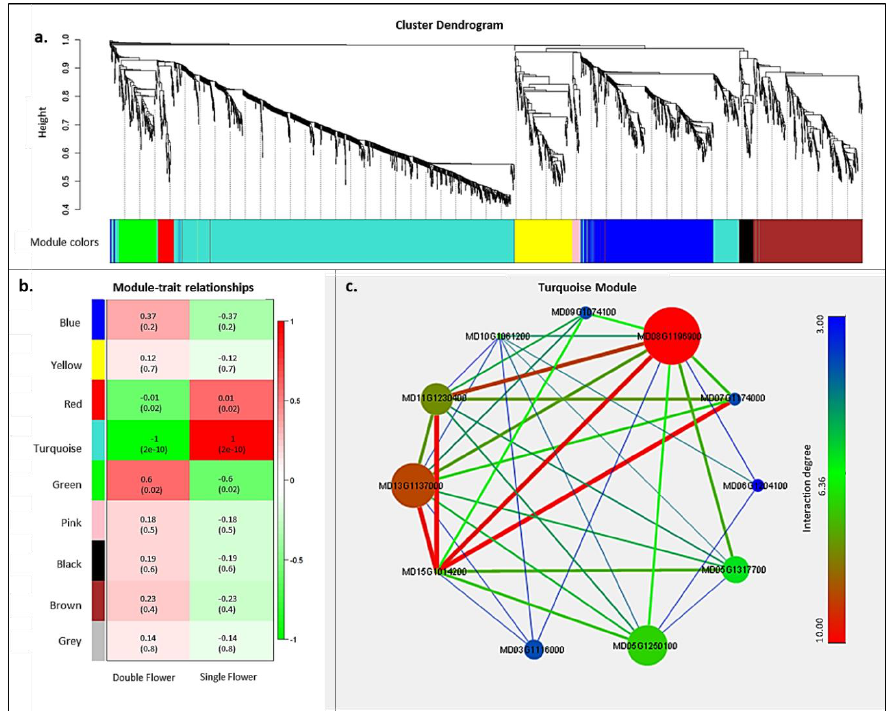
Figure 8. Weighted gene co-expression network analysis (WGCNA) of DEGs identified from double flower and single flower comparison. ( a ) Hierarchical cluster tree showing nine modules of co-expressed genes. Each of the DEGs used in this analysis is represented by a tree leaf and each of the modules by major tree branch. The panel below shows the colors representing each module. ( b ) Module-trait relationships (correlation) and corresponding p -values (given in parenthesis). On the left side the panel shows nine modules while the color scale on the right shows the correlations ranging from −1 (green) to 1 (red). The left panel represents double flowering as a trait while the right panel represents the single flower as a trait. ( c ) Cytoscape network analysis of co-expressed genes with edge weights ≥ 0.1 in module “turquoise”. On the right the color scale represents the interaction degree of genes among each other ranging from 10 (red) to 3 (blue). The larger the size of the circle representing the gene the more the degree of outgoing interactions with other genes, while more thicker the edge line the greater the correlation efficiency.